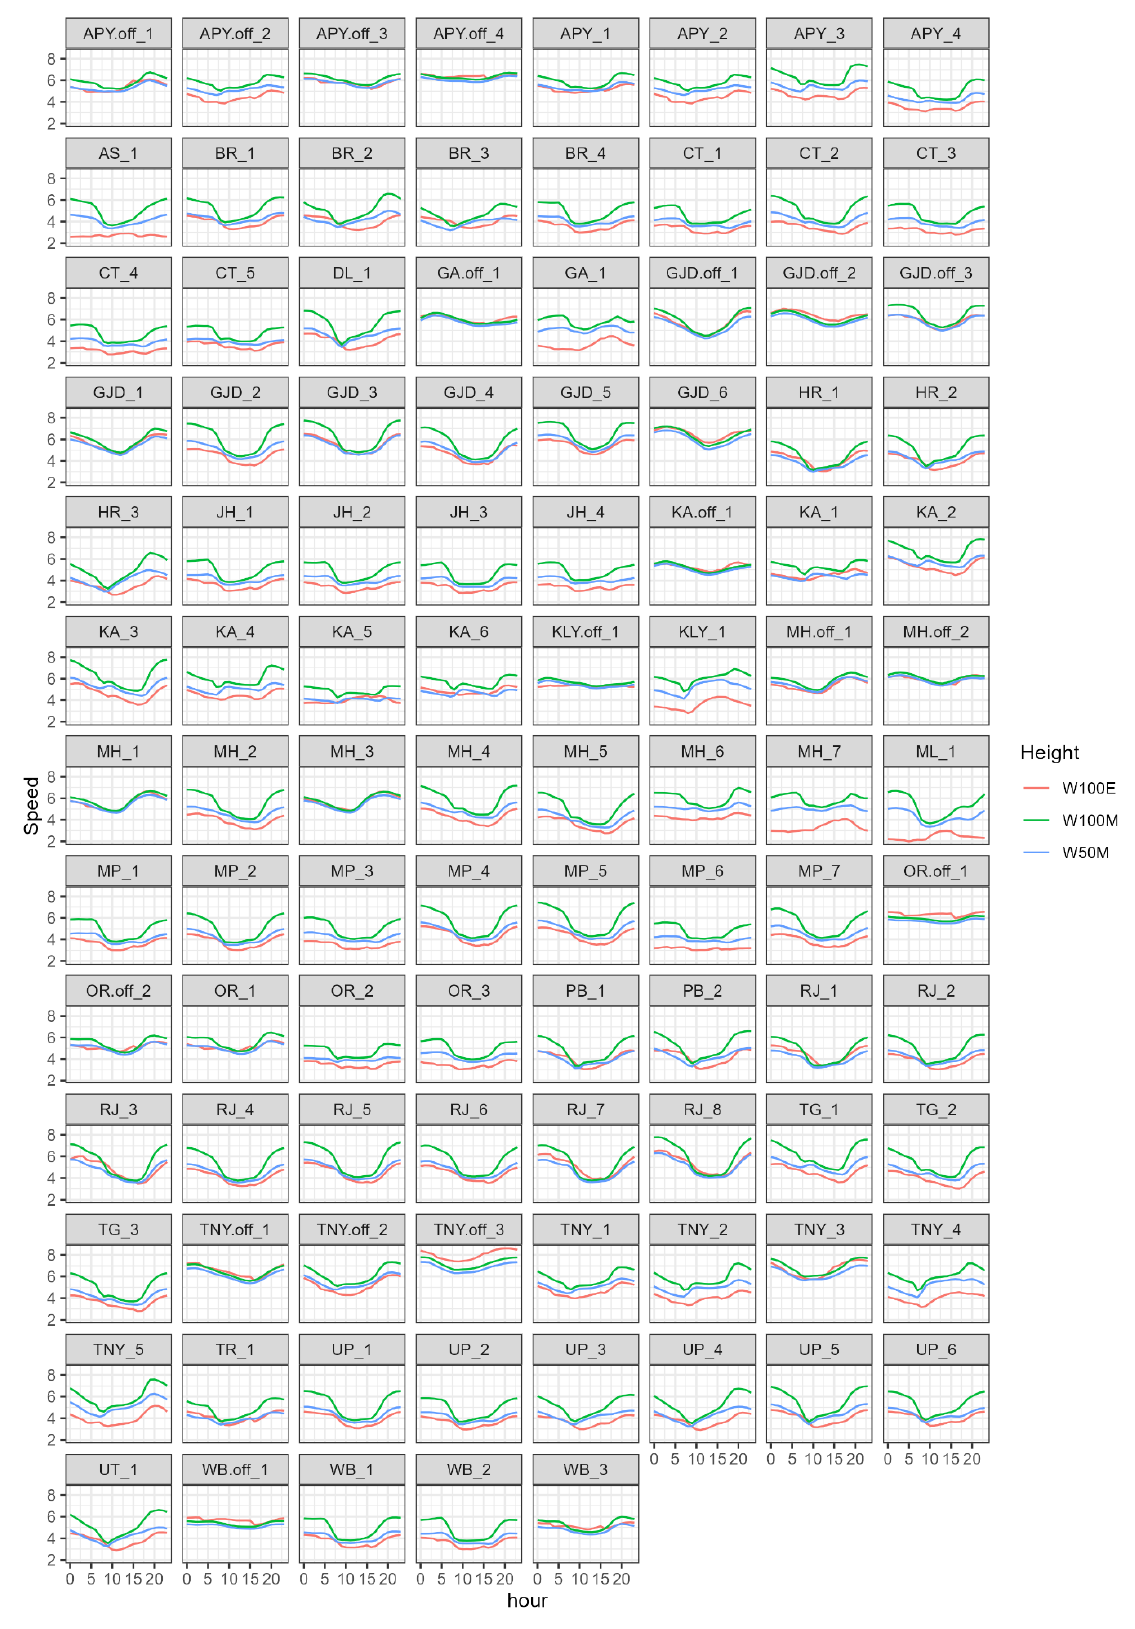
Figure A6. Annual average diurnal wind speed profiles in MERRA-2 and ERA5 datasets at 50 and 100 m height (W50M, MERRA-2; W100E, ERA5; W100M. MERRA-2 extrapolated), 2020 weather year.